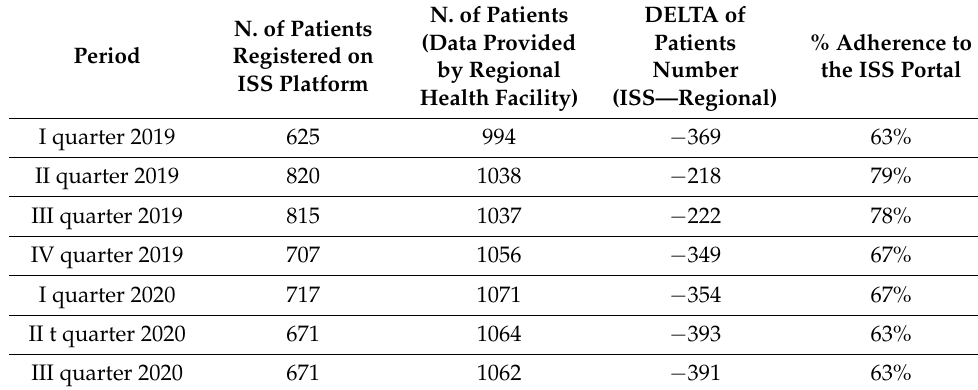
Table 4. Regional summary: number of prescriptions. Number of Period